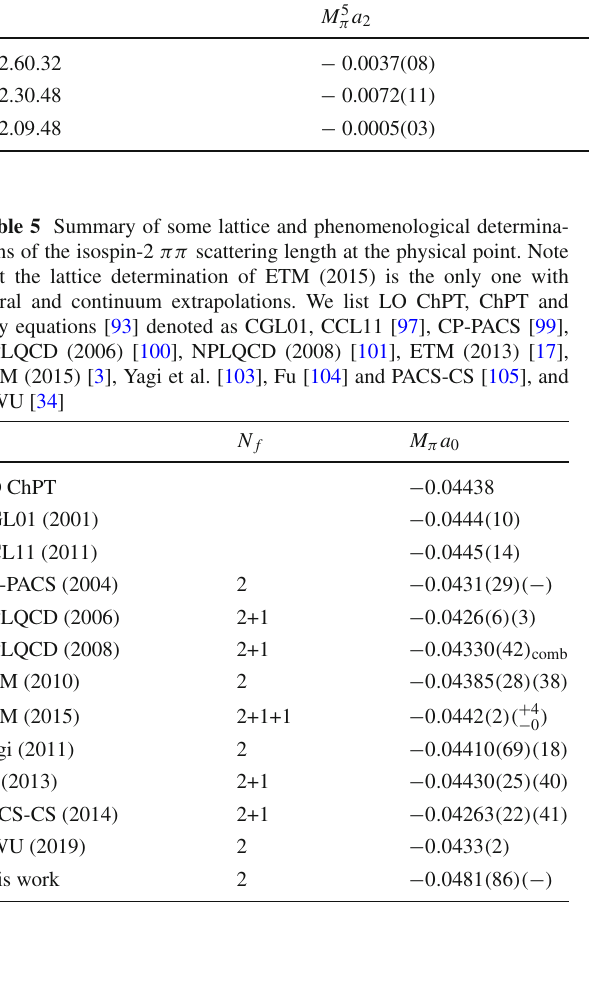
Table 4 d -wave two-pion fits to Eq. 8. Here we use only non- A 1 two-pion levels. The last column shows the energy range for which data is used